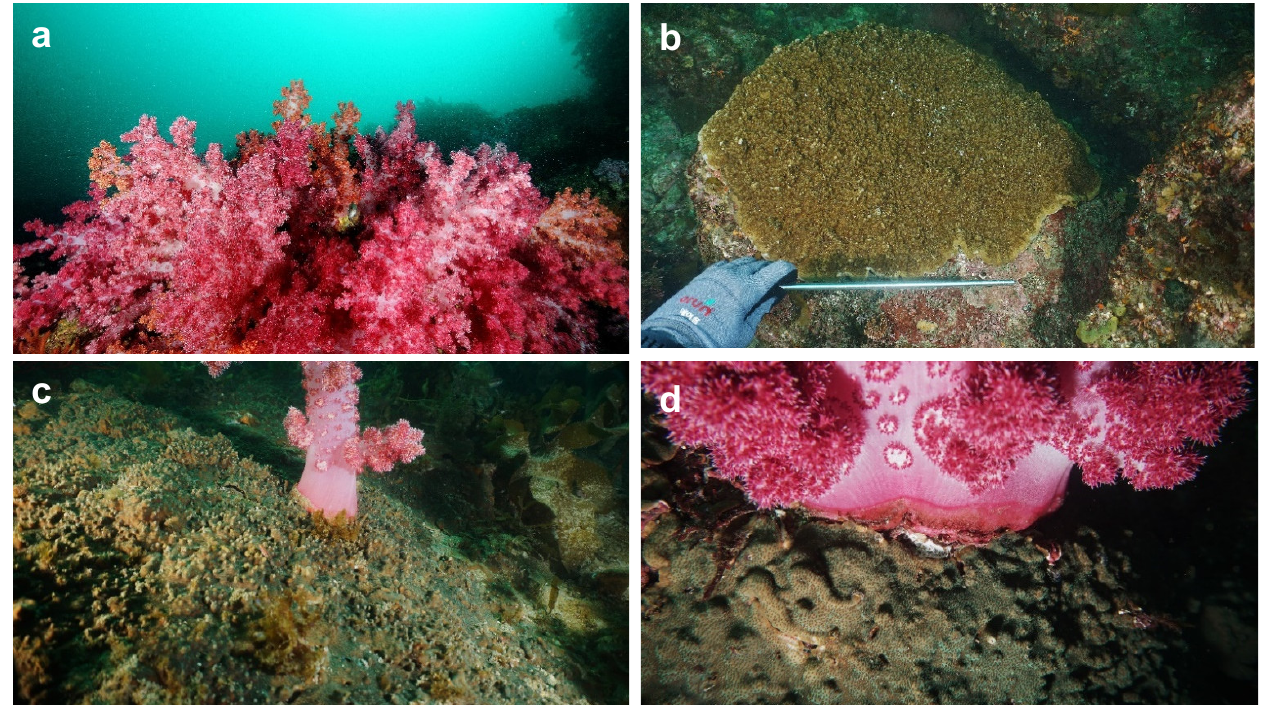
Figure 2. Photographic images of biotic interactions between soft and hard corals. ( a ) Communities of soft coral species Dendronephthya gigantea and Dendronephthya pütteri ; ( b ) encrusting morphotype of Montipora millepora; ( c ) D. gigantea enclosed by M. millepora ; ( d ) close-up image of M. millepora outcompeting D. gigantea .